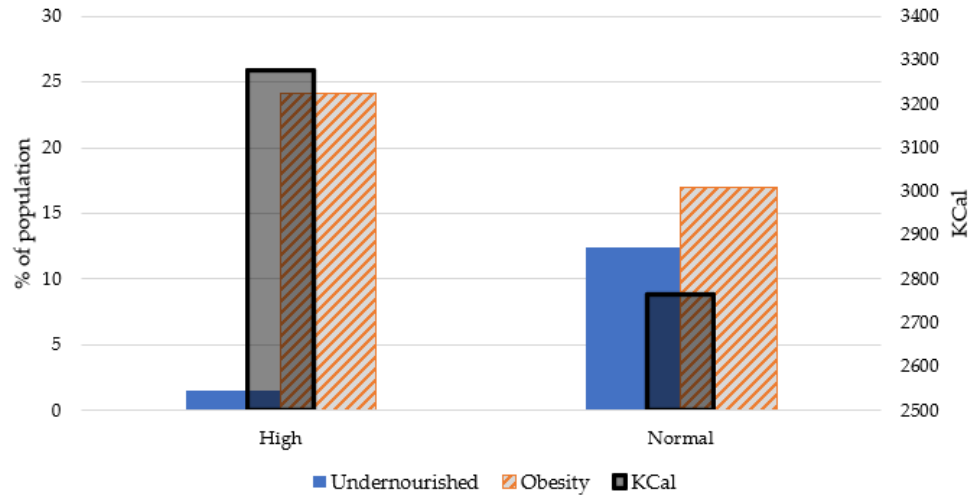
Figure 5. Obesity and undernourished diseases for high and normal death